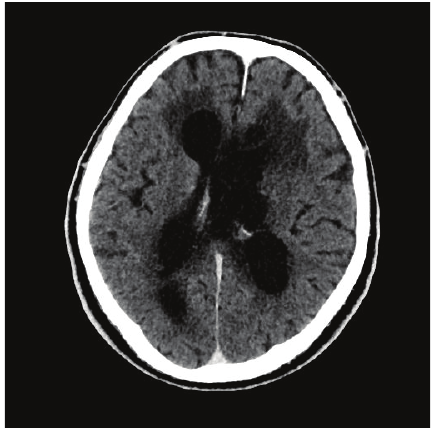
Figure 3: CT of the brain with intravenous contrast 6 months after admission showing progression of